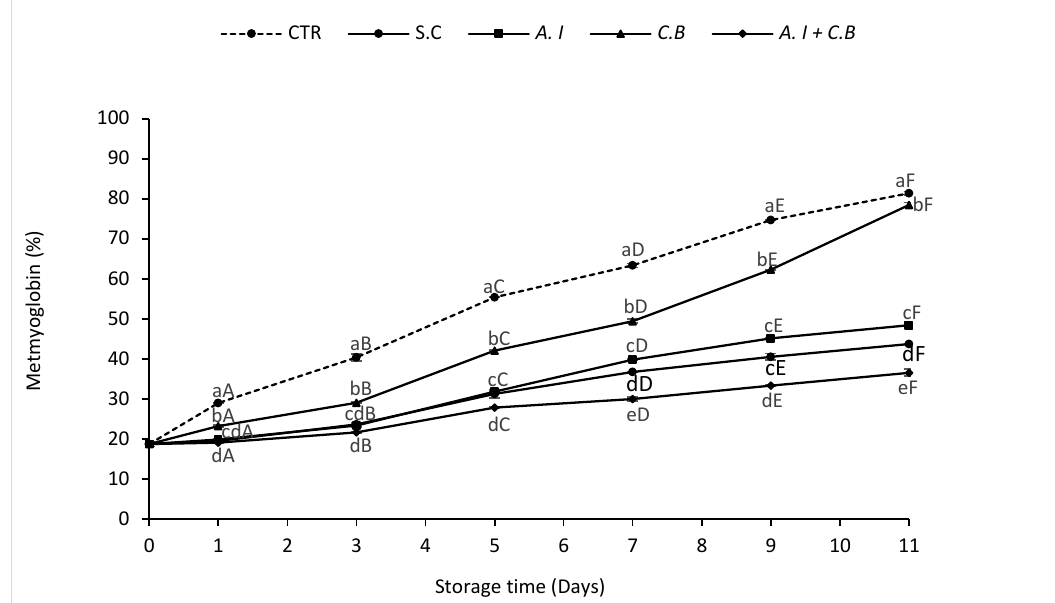
Figure 4. Effects of powdered A. indica leaves added at 0.7% (w/w) on MetMb changes in beef patties Figure 4. E ff ects of powdered A. indica leaves added at 0.7% (w / w) on MetMb changes in beef patties during 11 days of refrigerated storage at 4 ± 1 °C. CTR (Control sample without antioxidant), S.C during 11 days of refrigerated storage at 4 ± 1 ◦ C. CTR (Control sample without antioxidant), S.C (treatment with 0.7% (w/w) synthetic conservative), A.I (treatment with 0.7% (w/w) powdered A. (treatment with 0.7% (w / w) synthetic conservative), A.I (treatment with 0.7% (w / w) powdered A. indica indica leaves), C.B (treatment with 0.7% (w/w) powdered C. baccatum fruits) and A.I + C.B (treatment leaves), C.B (treatment with 0.7% (w / w) powdered C. baccatum fruits) and A.I + C.B (treatment with with 0.7% (w/w) powdered A. indica leaves and 0.7% (w/w) powdered C. baccatum fruits). Results 0.7% (w / w) powdered A. indica leaves and 0.7% (w / w) powdered C. baccatum fruits). Results represent represent the mean of three replicates ( n = 3) and are expressed as mean value ± SD; different letters the mean of three replicates ( n = 3) and are expressed as mean value ± SD; di ff erent letters in the in the same day indicate significant differences between samples at p < 0.05, different capital letters same day indicate significant di ff erences between samples at p < 0.05, di ff erent capital letters indicate significant differences between storage days at p < 0.05 for the same sample.